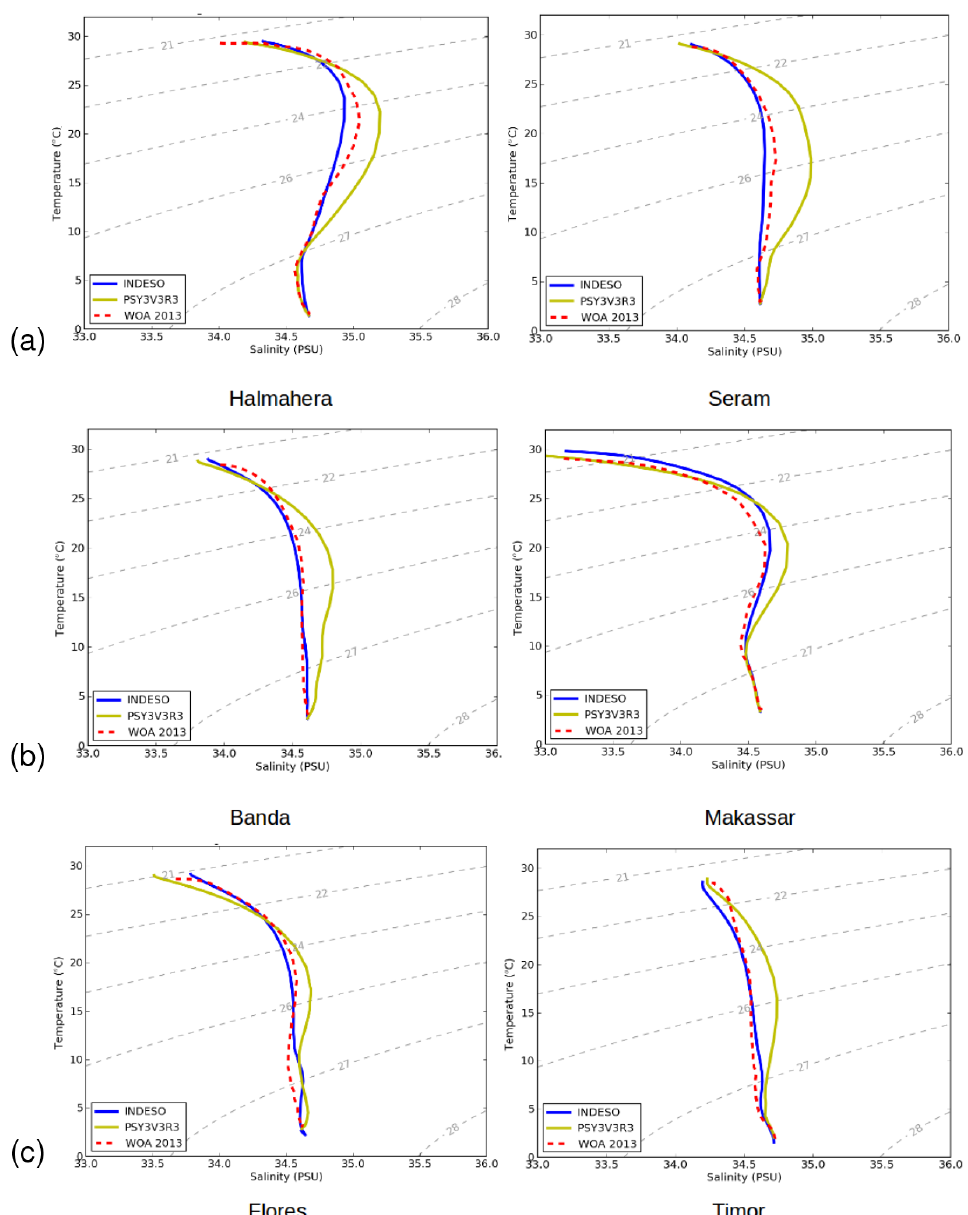
Figure 17. T – S diagrams from INDO12 simulation (blue line) averaged on different areas, (a) Halmahera Strait and Seram Sea, (b) Banda Sea and Makassar Strait, (c) Flores Sea and Timor Passage compared to climatologies WOA 2013 (red dotted line) and PSY3V3R3 (yellow line) for the 2008–2013 period. Salinity (PSU) and temperature ( ◦ C) are plotted along x and y axes,